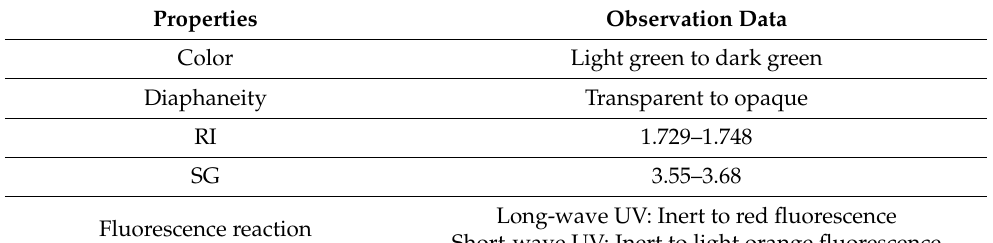
Table 1. Summary of gemological properties of tsavorites from Kenya and Tanzania.